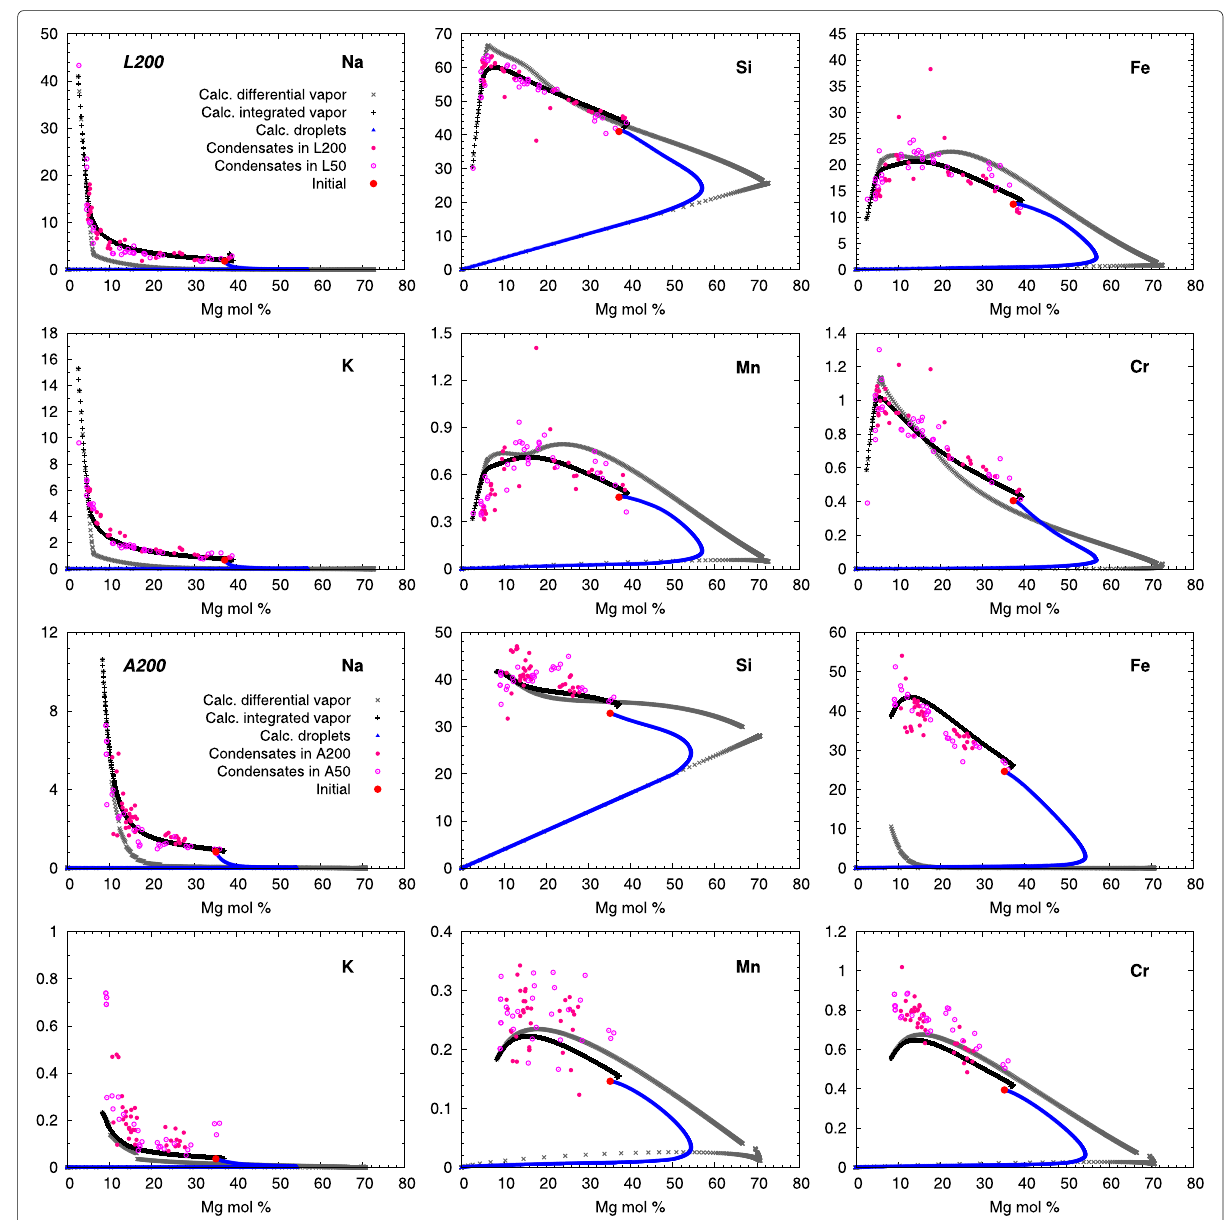
Fig. 8 Numerical reproduction of evaporation and condensation trajectories for the experiment groups L200 and A200. Element concentration in mol% is shown in each panel as a function of Mg mol%. ‘Calc. droplets’, ‘Calc. differential vapor’ and ‘Calc. integrated vapor’ are numerical results (see “Application of relative volatilities to an arbitrary MLB: self-consistency test” section). ‘Condensates in L200’ are the bulk compositions of the condensed particles in the experiments that belong to L200, and are compared to ‘Calc. integrated vapor’. The L50 data are added for